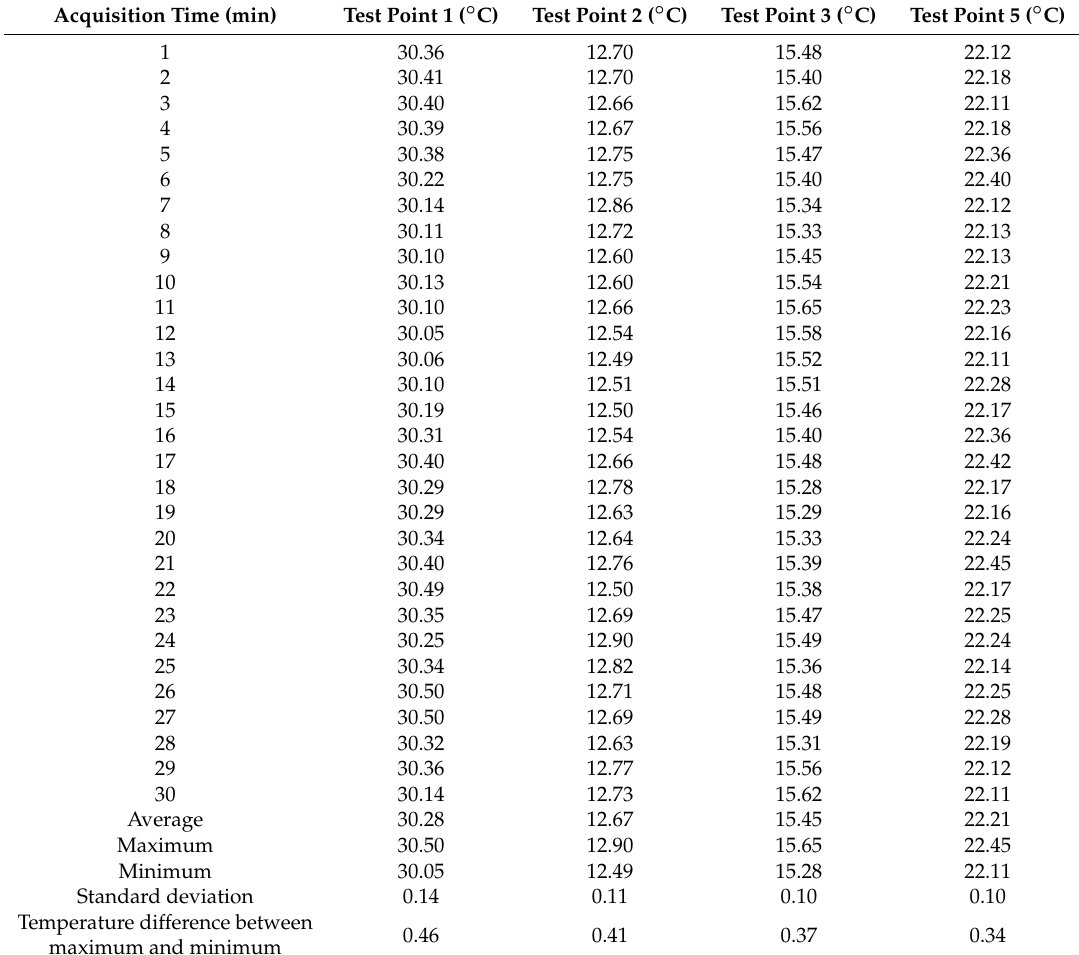
Table 3. Temperature of four test points at 30 ◦ C, 60%, 0.2 m 3